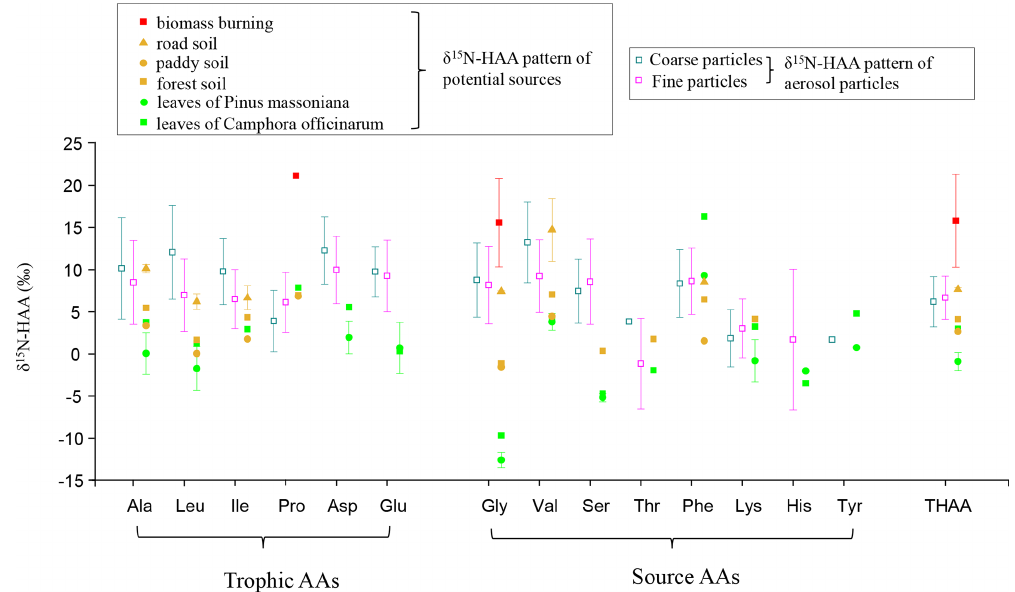
Figure 3. Comparison of δ 15 N-HAA patterns of fine and coarse aerosol particles with those of potential local sources.